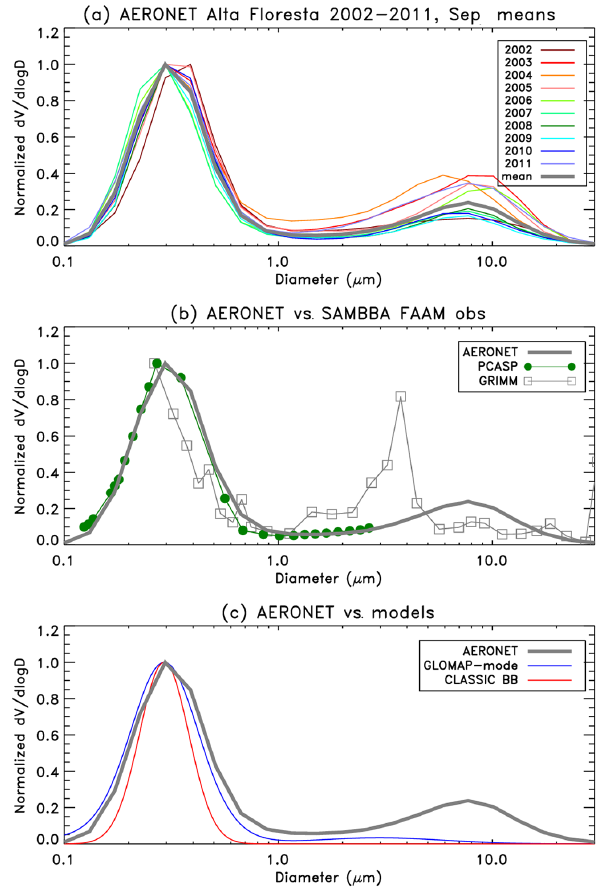
Figure 10. Aerosol volume size distributions (d V /dlog D µm 3 µm − 2 ) vs. particle diameter for (a) Septem- ber means from AERONET Alta Floresta (southern Amazonia) for 2002–2011 along with the long-term monthly mean from all years, (b) comparison of the AERONET 10-year September mean with FAAM averages from the SAMBBA West region, normalized by peak concentration, and (c) comparison of the AERONET 10-year September mean with HadGEM3 September monthly mean output, the column-integrated mean over Alta Floresta for GLOMAP-mode (all active size modes), and CLASSIC (BB species